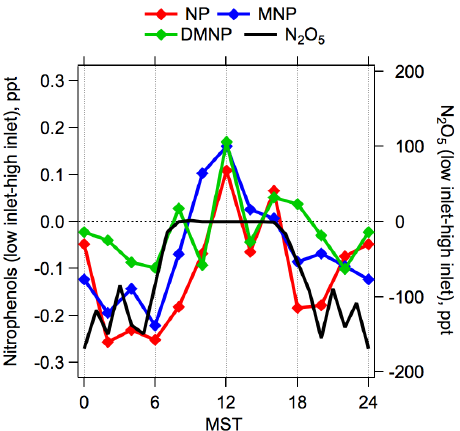
Figure 9. Diurnal profiles of vertical gradients for nitrated phenols measured in 22 January–1 February. The measured vertical gradient of N 2 O 5 measured in 6–14 February is also shown for